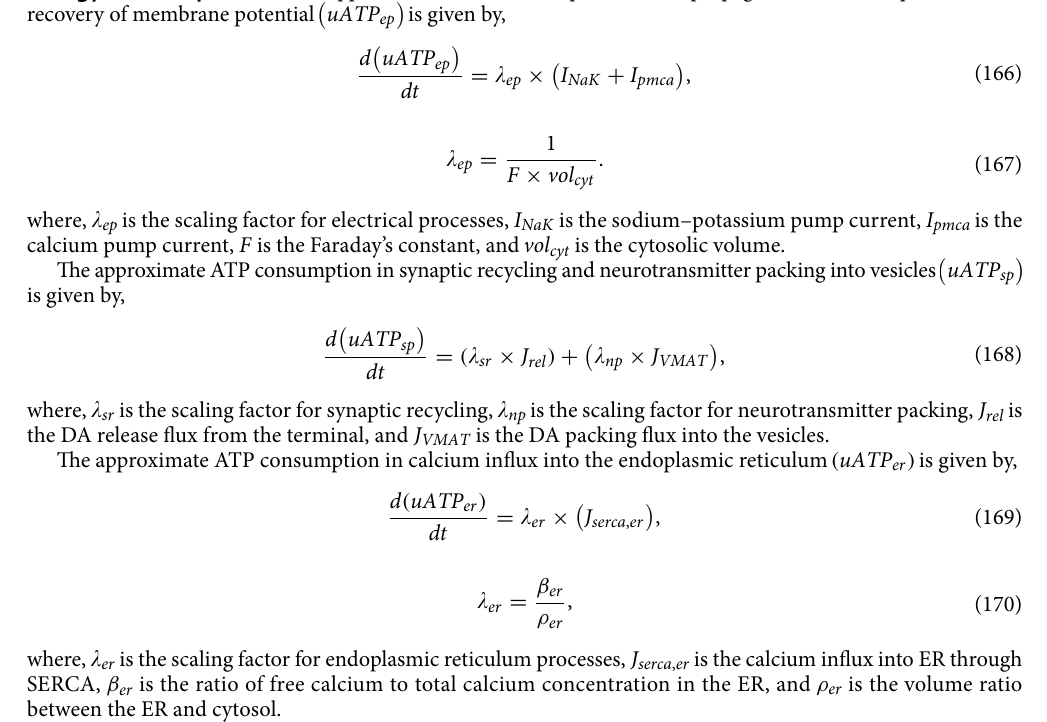
Figure 2. Oscillations in intracellular molecular concentrations in relation to the oscillations of the membrane potential. ( A ) Oscillations in the membrane potential (V) and the corresponding variations of intracellular sodium (Na + ), potassium (K + ) and calcium (Ca 2+ ) concentrations, ( B ) Oscillations in cytoplasmic (CP), endoplasmic reticulum (ER) and mitochondrial (MT) calcium concentrations and calcium-binding proteins (CBP—Cam & Calb) concentration in relation to the variation of the membrane potential, ( C ) Oscillations in cytoplasmic (CC), vesicular (VC) and extracellular (EC) dopamine (DA) concentrations in relation to the membrane potential, ( D ) Oscillations in fructose-6-phosphate (F6P), glyceraldehyde-3-phosphate (GAP), pyruvate (PYR), lactate (LAC) and adenosine triphosphate (ATP) concentrations in relation to the membrane potential, ( E ) Energy consumption by different cellular processes in the SNc cell, ( F ) Range bar plot of extracellular DA concentration with respect to nRRP. Cam Calmodulin, Calb calbindin, conc concentration, mM millimolar, mV millivolt, ATP adenosine triphosphate, AP action potential propagation, VR vesicle recycling, DP DA packing, DA dopamine, ES endoplasmic reticulum calcium sequestering, PD protein degradation, nRRP number of readily releasable vesicle